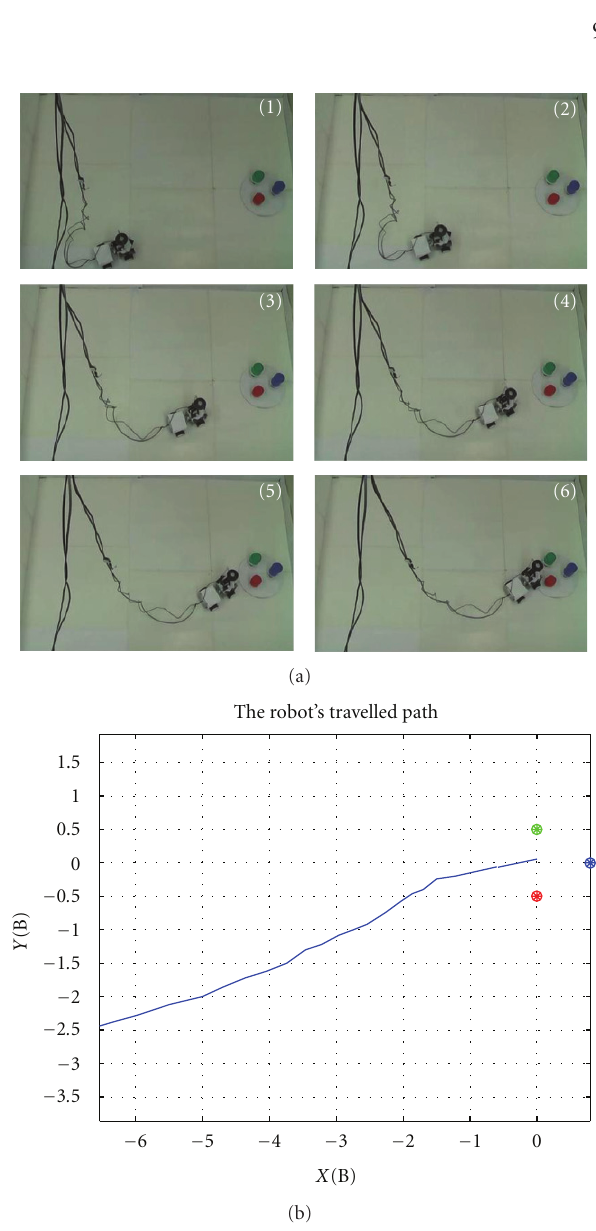
Figure 14: The robot is initially positioned at (7,5 π /8,0,0), (a) the snapshots of the experiment, (b) the traveled path of the